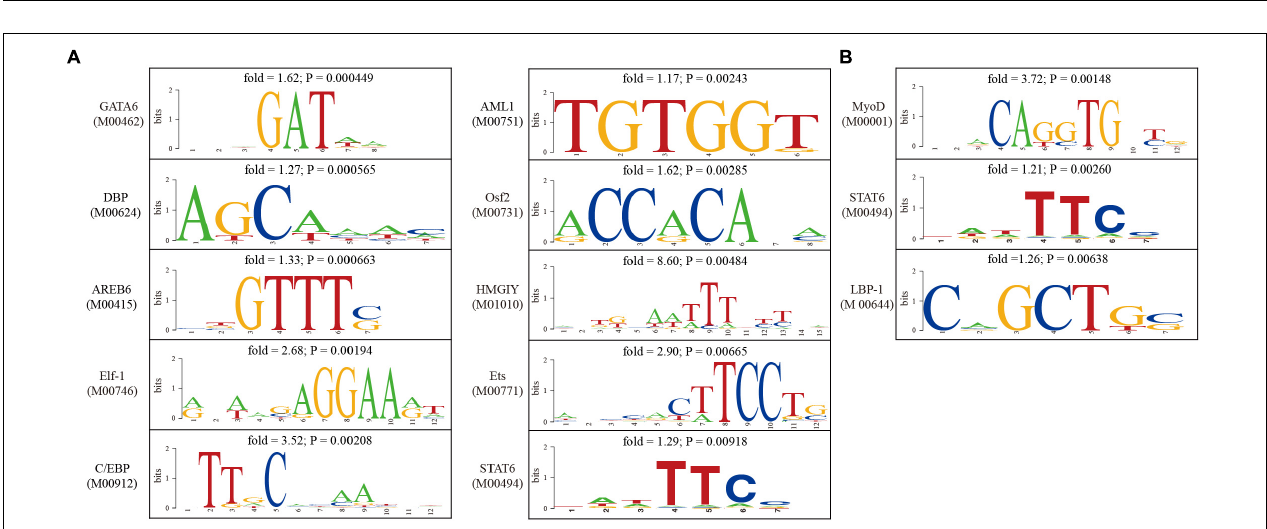
FIGURE 5 | Analysis of transcription factor binding sites in the promoter of differentially expressed genes. (A) The sequence logos for transcription factors whose binding sites were significantly enriched in the promoter of up-regulated genes. (B) The sequence logos for transcription factors whose binding sites were significantly enriched in the promoter of down-regulated